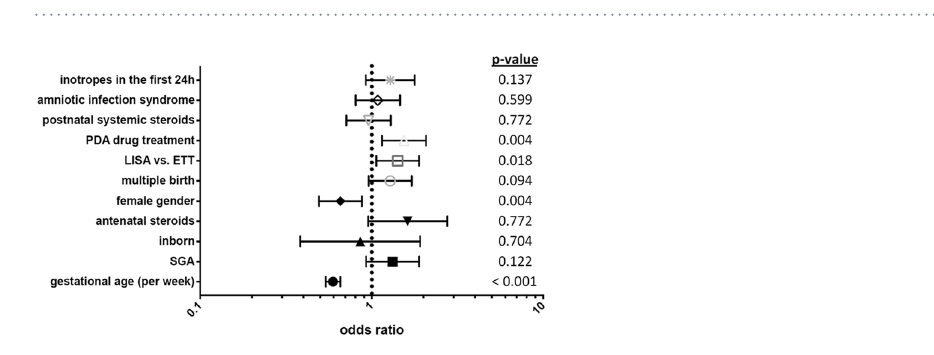
Figure 1. Incidence of FIP stratified to primary surfactant management. The figure depicts the percentage of infants suffering from FIP per week of gestation according to exposure to surfactant treatment: Surfactant via ETT (white bars), Surfactant via LISA (grey bars). Numbers of infants are given below each column, i.e. surfactant treated infants via ETT/surfactant treated infants via LISA in each week of gestation.